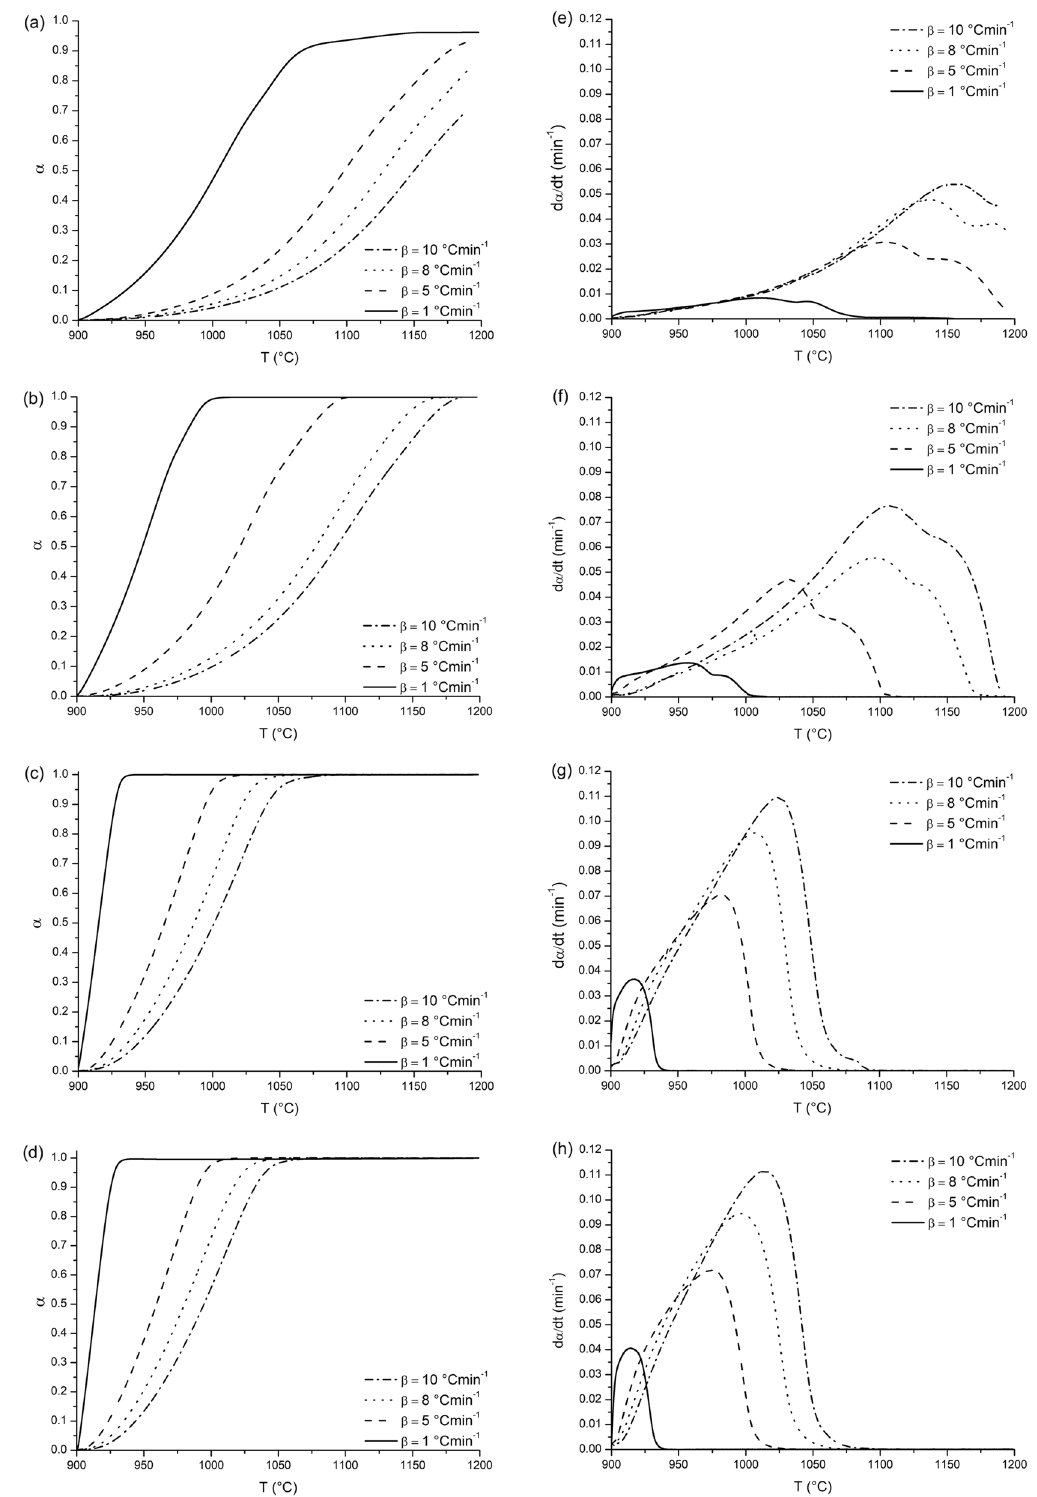
Figure 5. Plots of α and dα/dt against T (°C) for different heating rates. ( a ) GCI coal, α against T. ( b ) GCI coal melt-blended with 20 wt.% facemask material, α against T. ( c ) Charcoal, α against T. ( d ) Charcoal melt-blended with 20 wt.% facemask material, α against T. ( e ) GCI coal, dα/dt against T. ( f ) GCI coal melt-blended with 20 wt.% facemask material, dα/dt against T. ( g ) Charcoal, dα/dt against T. ( h ) Charcoal melt-blended with 20 wt.% facemask material, dα/dt against